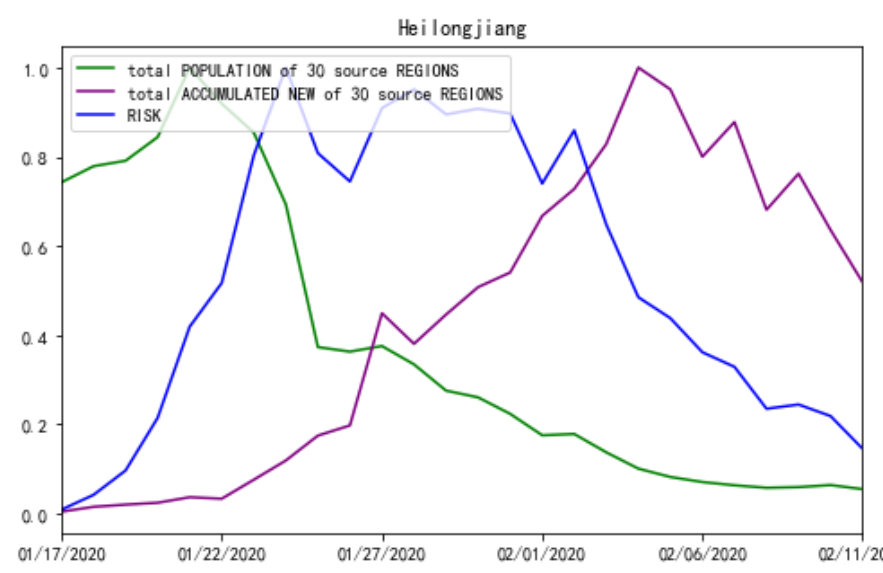
Figure 3. RISK of Heilongjiang Province from January 17, 2020 to February 11, 2020.